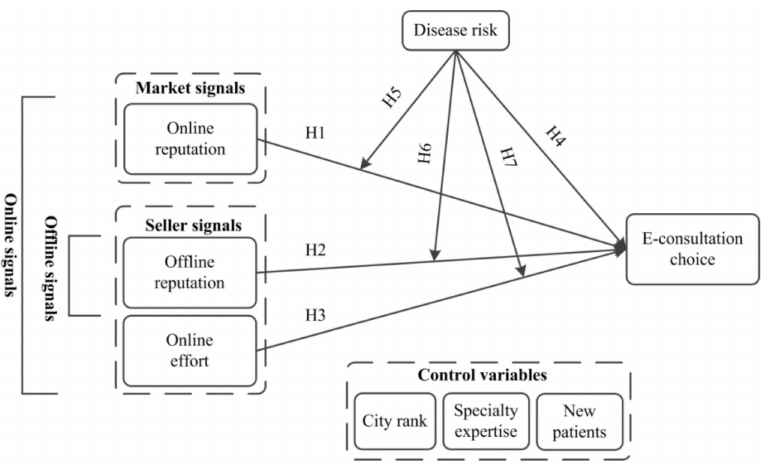
Figure 1. Research